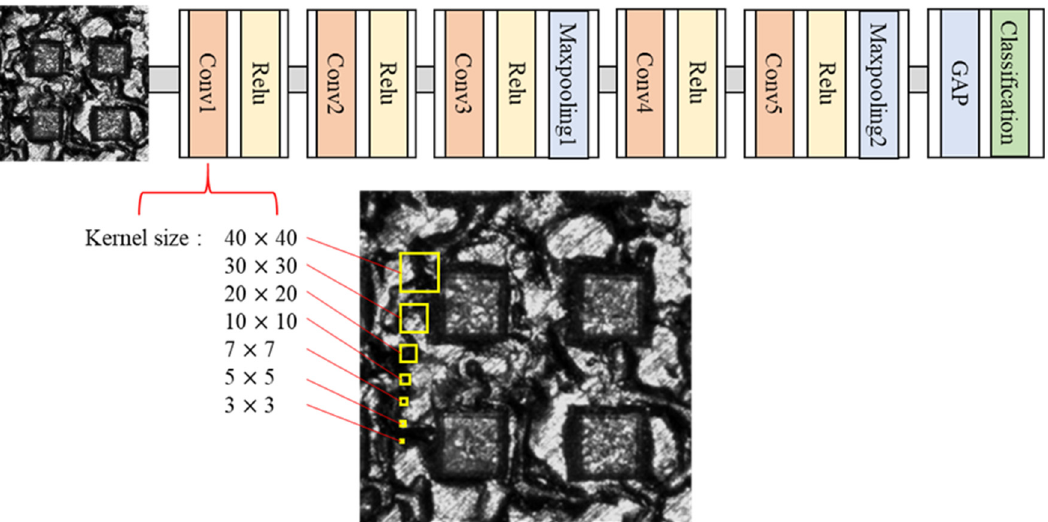
Figure 8. Modification of kernel size at the 1st convolutional layer.